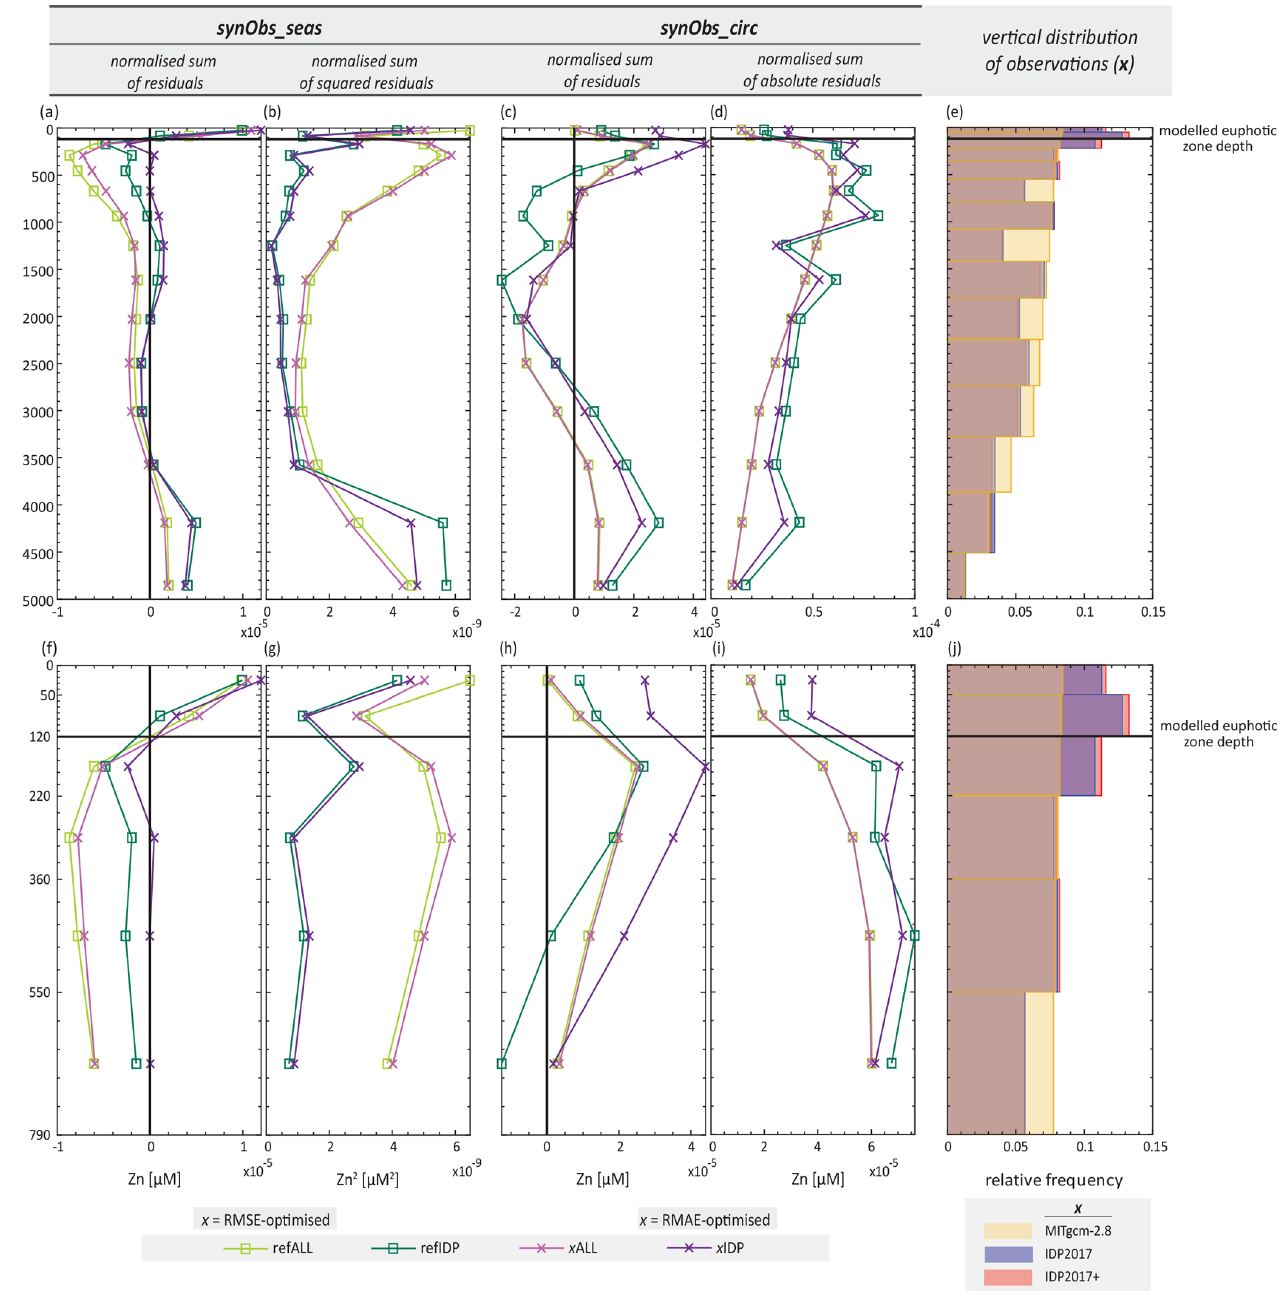
Figure 10. (a, c) Integrated reference residuals (i.e. Zn reference –Zn target ) and residuals of optimised model over each model depth level. (f, h) Zoom-ins of panels (a) and (c) . (b, g, d, i) Same as panels (a) , (f) , (c) , and (h) , but the integration is done with residuals being squared and with absolute values of residuals, respectively. In order to make results obtained with the two data situations comparable, all results are normalised by the total number of observations. Note that positive and negative residuals within the same depth level can cancel each other out and that the sum is influenced by the number of model cells located in the corresponding model depth level. (e) Relative frequency distributions of the vertical distribution of three different observational sets, which are the non-reduced observations, i.e. MITgcm-2.8, IDP2017, and IDP2017 + , and (j) a zoom-in